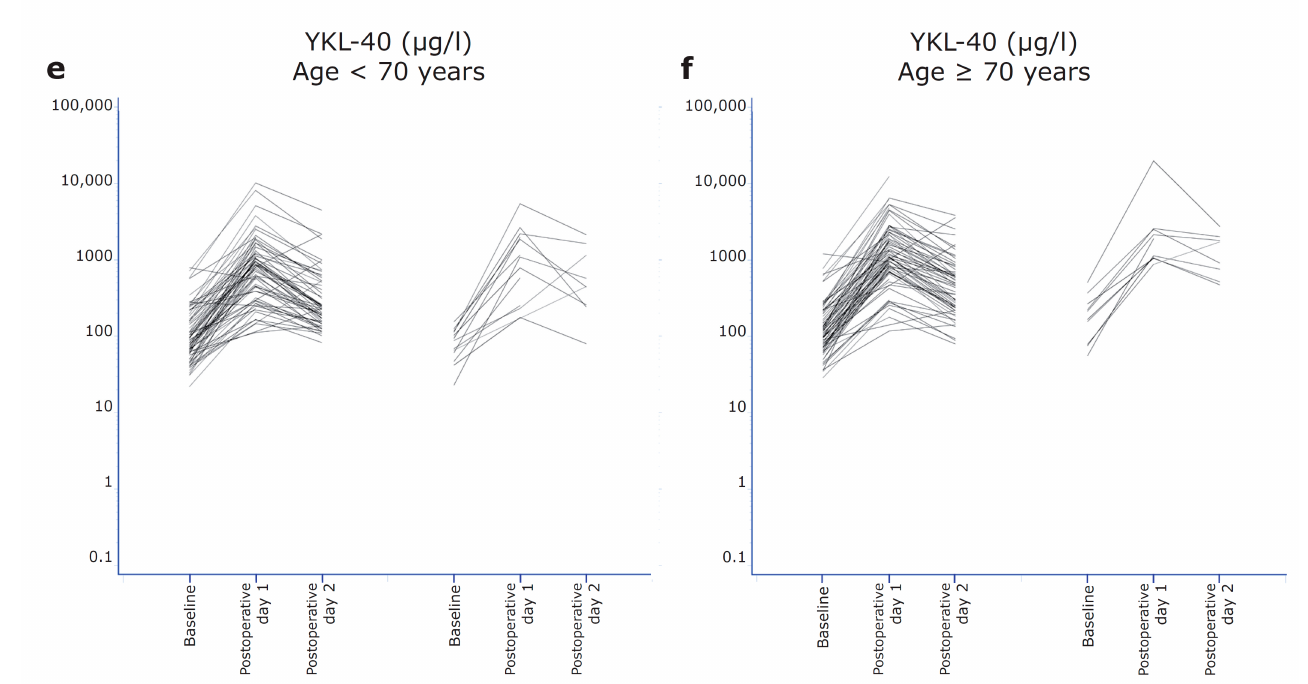
Figure 3. Spaghetti plots for biomarker levels (log scale) in pre- and postoperative serum samples. The figure illustrates patients with a surgical course without major complications (left) and patients with a surgical course with major complications (right). ( a ) CRP age <70 years. ( b ) CRP age ≥ 70 years. ( c ) IL-6 age <70 years. ( d ) IL-6 age ≥ 70 years. ( e ) YKL-40 age <70 years. ( f ) YKL-40 ≥ 70